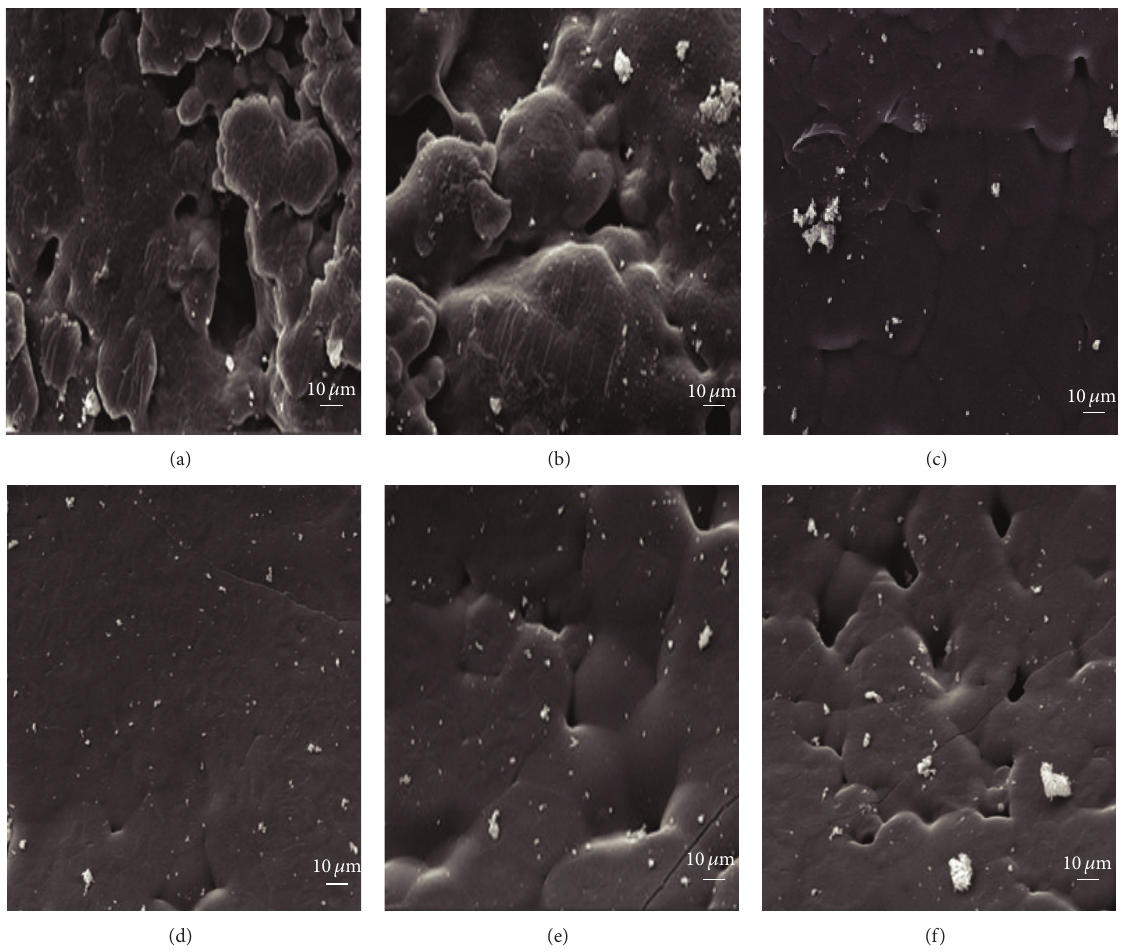
Figure 2: Surface of PVDF scaffolds sintered at energy density of (a) 0.66; (b) 0.96; (c) 1.26; (d) 1.56; (e) 1.86; (f) 2.16 J/mm 2